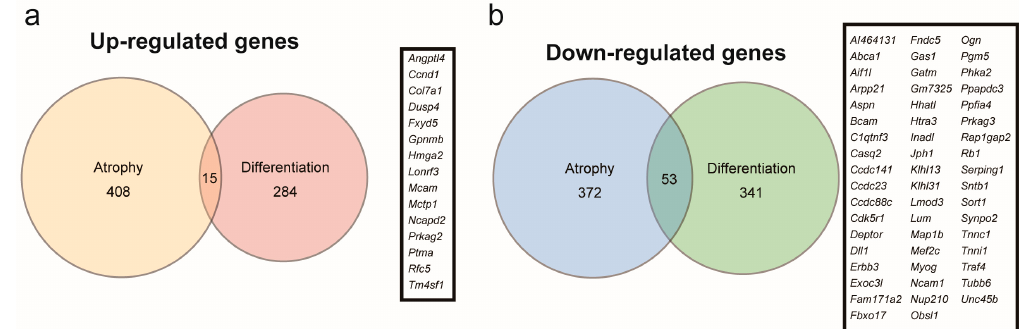
Figure 4. Comparison of genes commonly regulated by Myoparr knockdown between myogenic differentiation and muscle atrophy. ( a ) The intersection of genes upregulated by Myoparr knockdown in both skeletal muscle atrophy (423 genes) and myogenic differentiation (299 genes) showed low commonality. Gene symbols of the 15 commonly upregulated genes by Myoparr knockdown in both myogenic differentiation and muscle atrophy were shown in the panel. ( b ) The intersection of genes commonly downregulated by Myoparr knockdown in both skeletal muscle atrophy (425 genes) and myogenic differentiation (394 genes) also showed low commonality. Gene symbols of 53 commonly downregulated genes in both myogenic differentiation and muscle atrophy were shown in the panel.